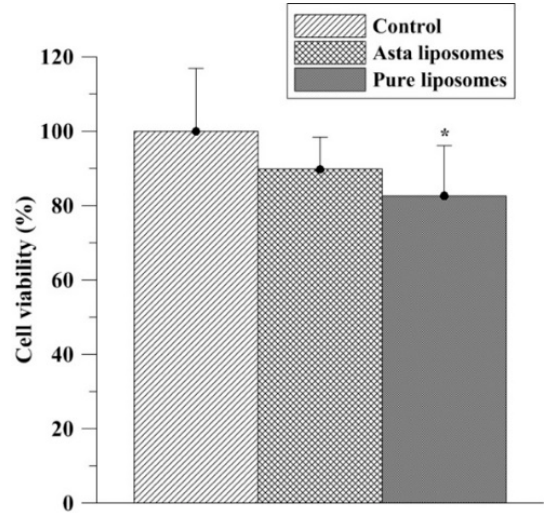
Figure 2. Effects of pure liposomes and Asta liposomes (Asta-lipo) at 0.01 mg/mL on the viability of L929 fibroblasts assessed using the 3-(4,5-dimethylthiazol-2-yl)-2,5-diphenyltetrazolium bromide (MTT) assay after 24-h incubation. Control stands for incubation with the vehicle for the same period (24 h) as Asta-lipo and pure liposomes. Pure liposomes slightly but significantly reduced the viability of the normal fibroblasts ( N = 3, data are presented as the mean ± SEM, * P < 0.05 by ANOVA compared to control).